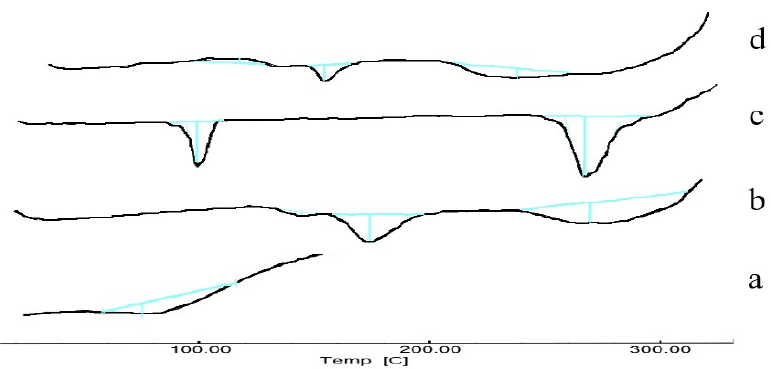
Figure 7. DSC thermograms; a, VAN; b, PL-90 G; c, CTAB; d, LPX formula. Abbreviations: DSC,